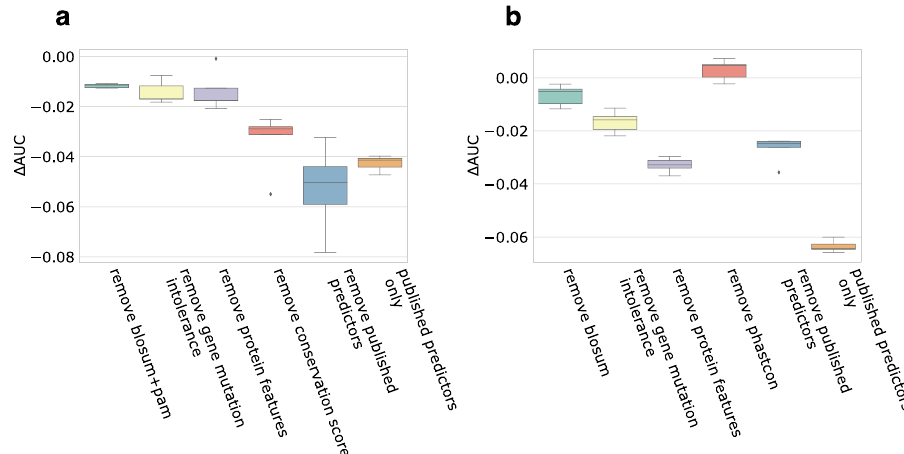
Fig. 2 Measuring the contribution of features to MVP prediction performance in cancer mutation hotspots data. Performance contribution is measured by AUC reduction ( Δ AUC) from excluding a group of features. Since features within a group is often highly correlated, we did measure the contribution of an entire group instead of individual features in the group. a Constrained genes ( b ) Non-constrained genes. We subsampled negatives from DiscovEHR database and calculated Δ AUC 15 times and estimated the error bar. The box bounds the interquartile range (IQR) divided by the median, and Tukey-style whiskers extend to a maximum of 1.5× IQR beyond the